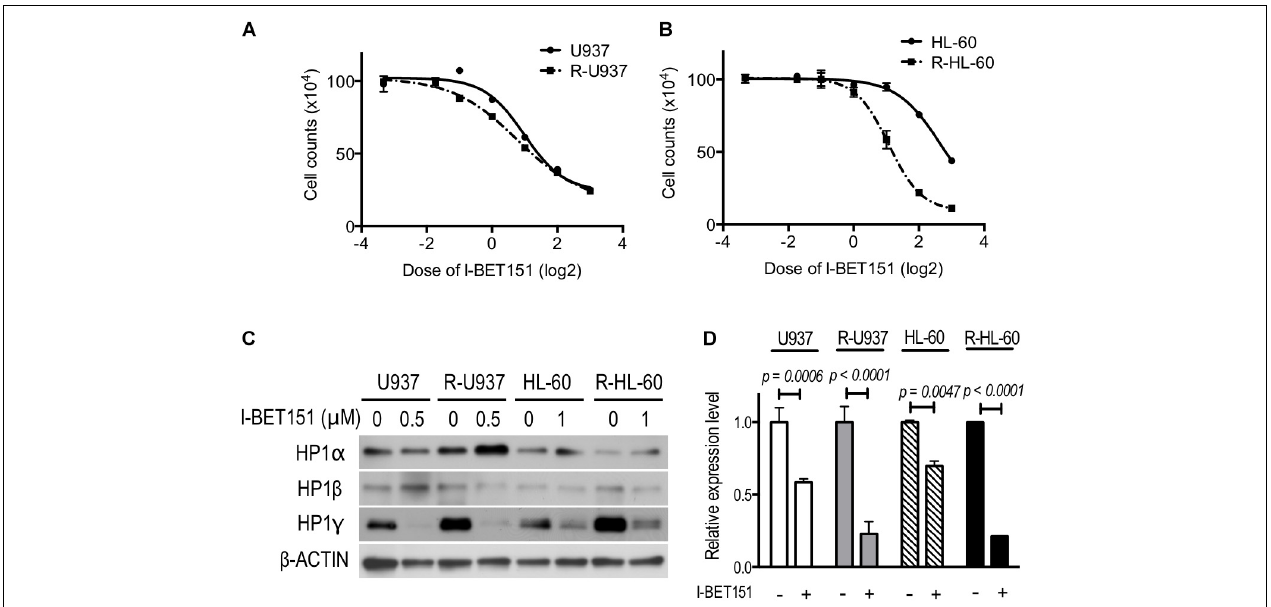
FIGURE 5 | The drug response curve using the cell counts of (A) U937 (solid line) and R-U937 cells (dotted line) and (B) HL-60 (solid line) and R-HL-60 cells (dotted line) after incubation with 0.1, 0.3, 0.5,1, 2, 4, and 8 µ M I-BET151 for 72 h. For each cell set, the mean ± SD from three independent experiments are shown. (C) Protein expression levels of HP1 α , β , and γ in U937, R-U937, HL-60, and R-HL-60 cells after incubation with I-BET151 at indicated dose for 48 h. Typical blots from a representative experiment are shown. The experiments were repeated three times. (D) Relative mRNA expression of HP1 γ after incubation with (+) or without (–) I-BET151 for 48 h. The concentration of I-BET151 was 0.5 µ M for U937 and R-U937 cells and 1 µ M for HL-60 and R-HL-60 cells. The mean ± SD from three independent experiments are shown. P -values < 0.05 were